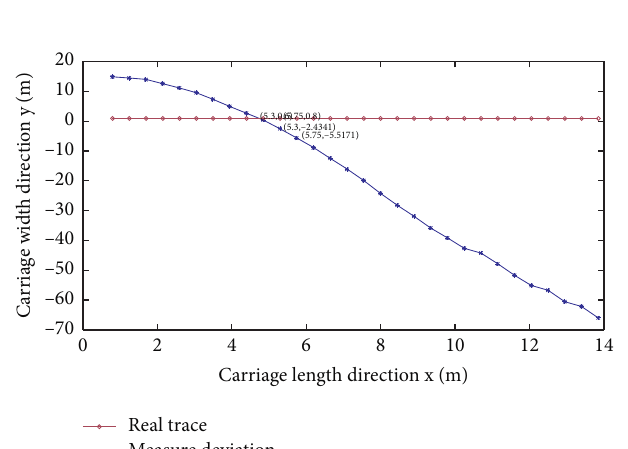
Figure 8: Simulation results.